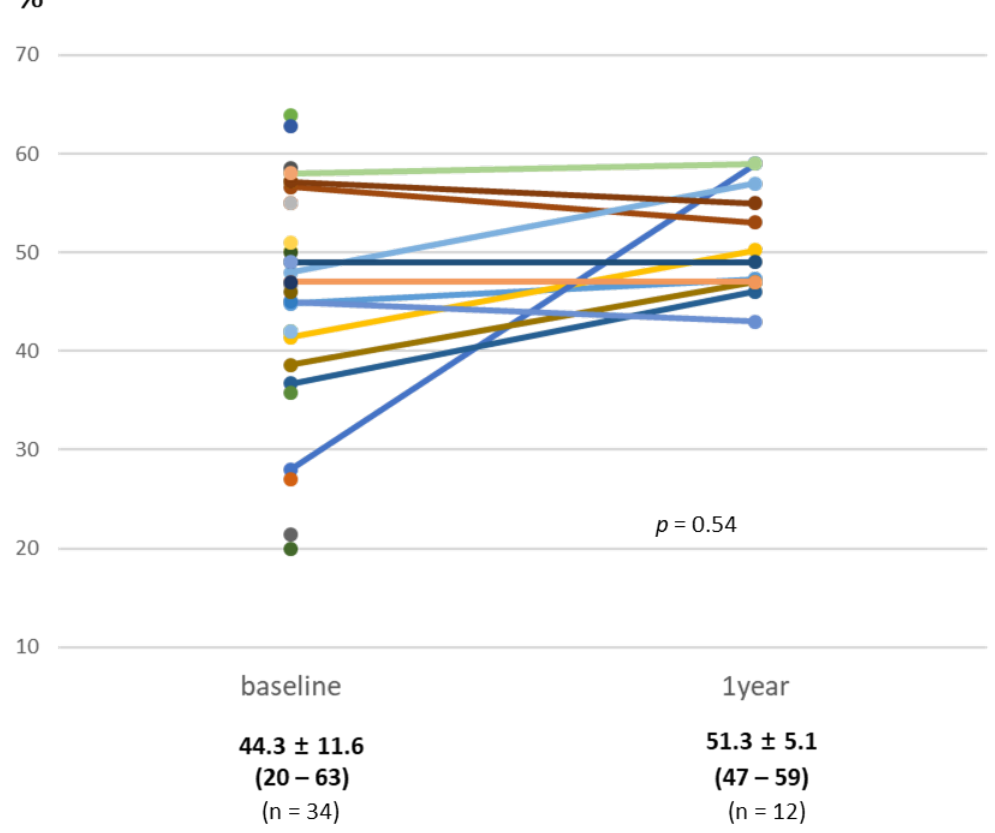
Figure 4. RV (right ventricle) ejection fraction (%) over time, as seen with cardiac MRI (magnetic resonance image). Values are presented as the mean ± standard deviation (range).